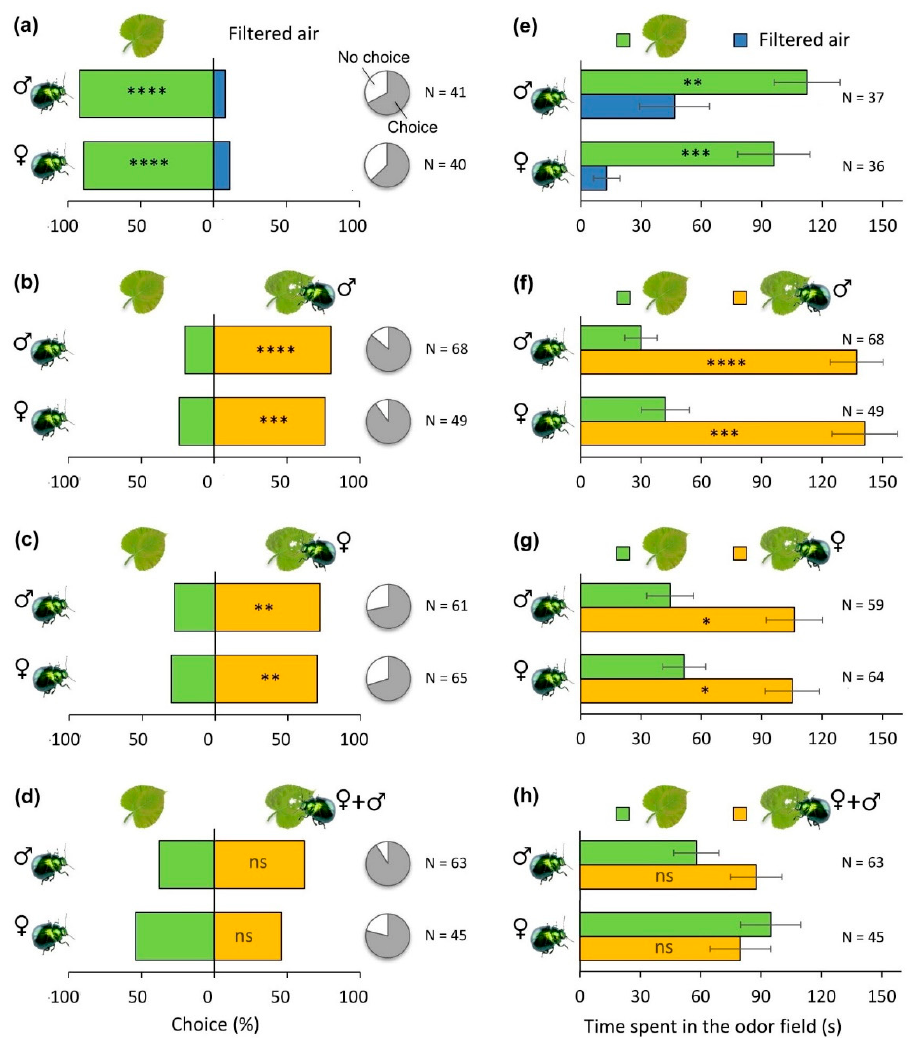
Figure 2. Attraction of P. laticollis adults to volatiles released from undamaged and damaged hybrid aspen seedlings. ( a – d ) Proportion of insects choosing the two odors, where the pie charts illustrate the relative proportion of insects that made or did not make a choice. ( e – h ) Average residence time (mean ± SEM) spent by insects in the two odor fields. Seedlings were subjected to feeding by leaf beetles for approximately 48 hours, followed by dual-choice olfactory assays in Y-shaped olfactometers. The following odor pairs were tested for both female ( ♀ ) and male ( ♂ ) adults: ( a , e ) undamaged leaves versus charcoal filtered air, ( b , f ) undamaged leaves versus leaves damaged by male adults, ( c , g ) undamaged leaves versus leaves damaged by female adults, and ( d , h ) undamaged leaves versus leaves damaged by a mixture of female and male adults ( ♀ + ♂ ). Significant differences in proportion data and residence time were assessed by binomial tests and Wilcoxon matched-pair signed-rank tests, respectively. Asterisks indicate significance level: * p < 0.05, ** p < 0.01, *** p < 0.001, **** p < 0.0001, ns, not significant.